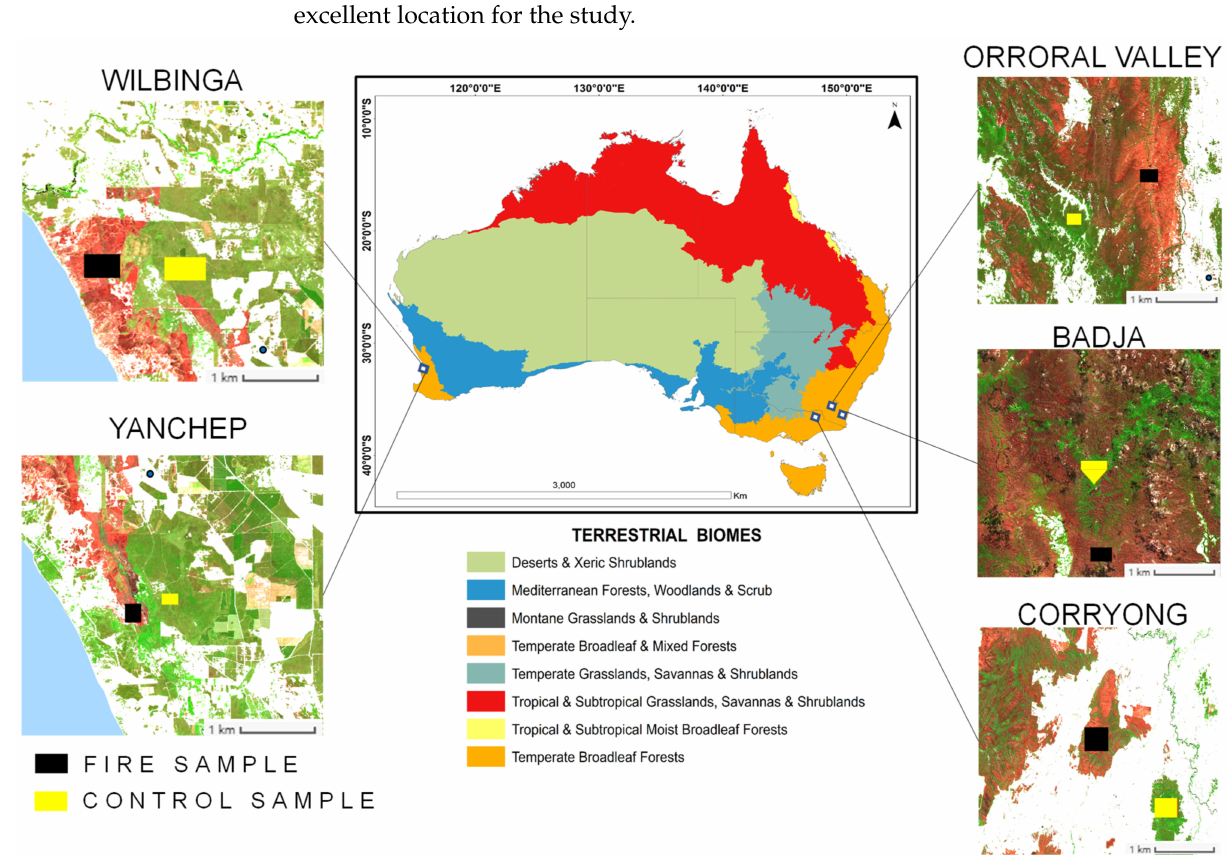
Figure 2. Overview of different terrestrial biomes [56] and five wildfires. The illustrations represent the fire sample (black) and control sample (yellow) masks for wildfires in VIC (Victoria), NSW (New South Wales), ACT (Australian Capital Territory), and WA (Western Australia). The base maps are Band12/Band 8/Band 4 infrared colour composites of the Sentinel-2 acquisition of the nearest date (post-fire) to the wildfire event (Table 1). Table 1. Characteristics of the five wildfires that were analyzed across four different study areas in Australia [57]. The total number of available Sentinel-1 (S1) and Sentinel-2 (S2) satellite scenes, date and location of the wildfires, and closest scene to the wildfire are also shown, as well as the size of the wildfire and control samples. Terrestrial biomes are a representation from